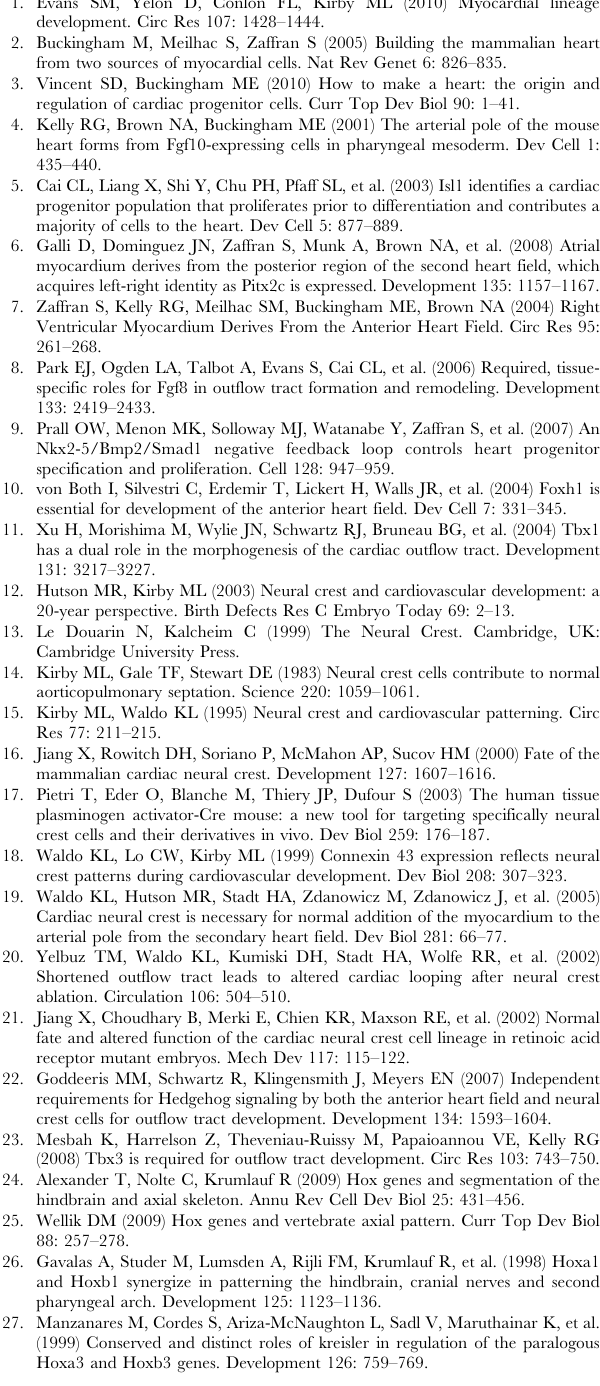
Figure S2 Schematic representation of the proximal 2- kb promoter of Hoxa3 used to generate the Hoxa3-lacZ reporter transgene. The Asp718-NruI 2-kb genomic fragment from the mouse Hoxa3 locus was fused to the E. coli lacZ coding sequence to generate the reporter transgene. The sequence of the 5 9 moiety of the promoter is shown and contains a predicted DR5 RARE site (underlined bold italics). Asp718 and XbaI restriction sites are shown in bold